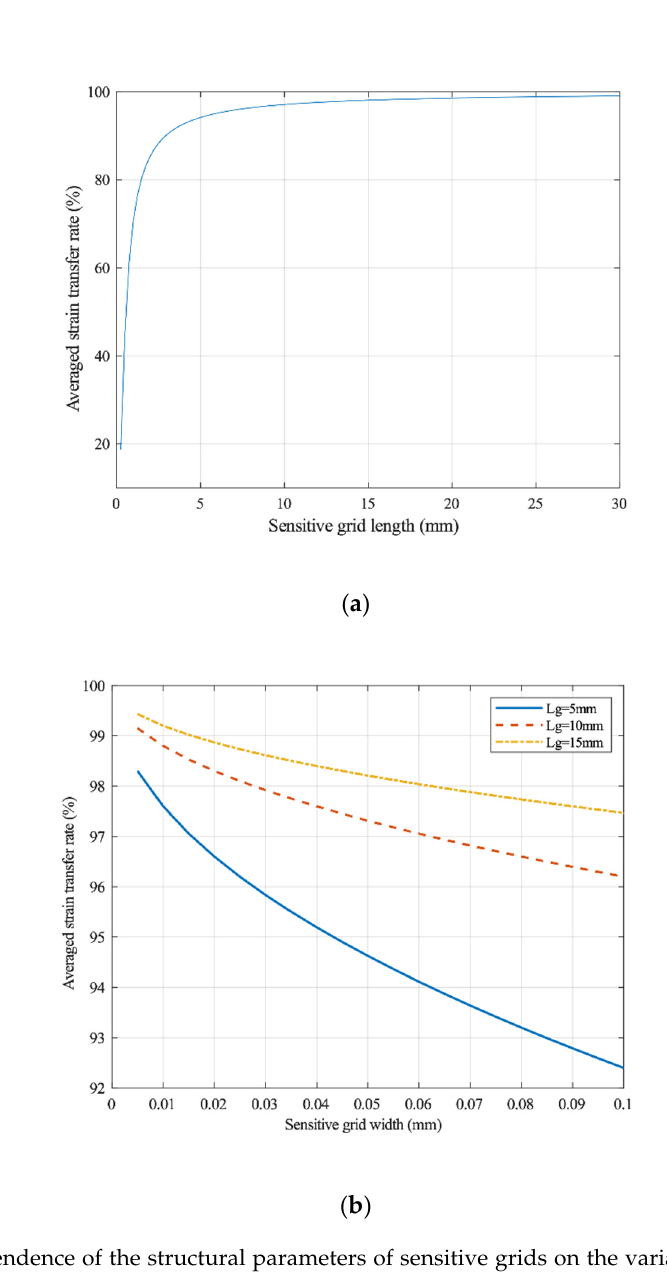
Figure 7. Dependence of the structural parameters of sensitive grids on the variable transfer ratio. ( a ) Sensitive grid length and ( b ) sensitive grid width [22]. L g is the length of the sensitive gate.